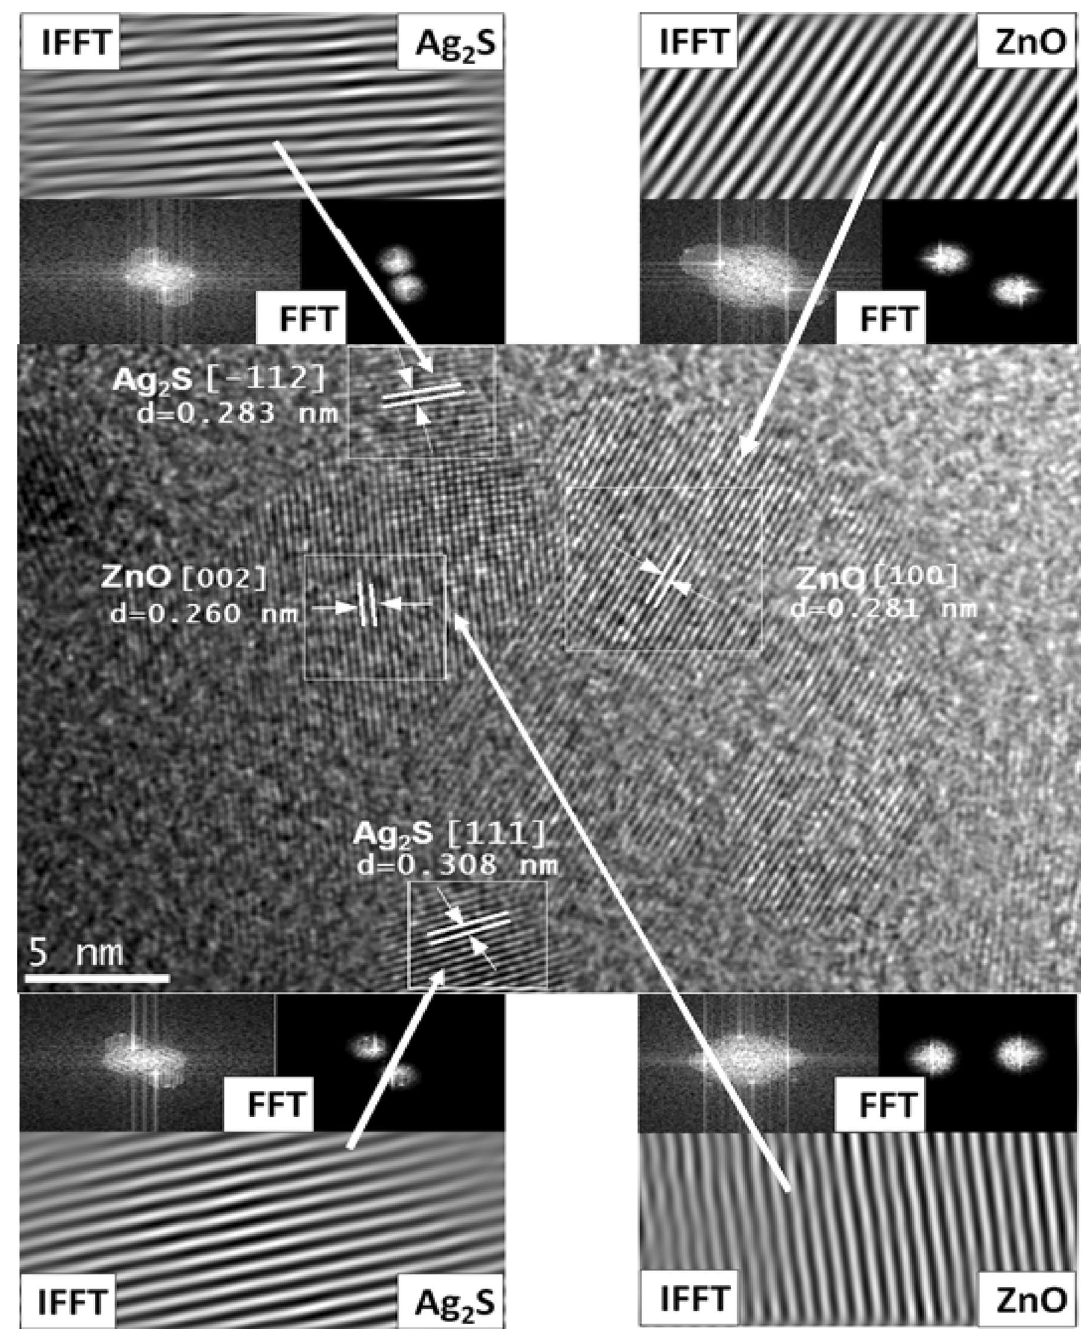
Figure 6. HRTEM image of the Ag 2 S/ZnO and diffraction patterns via FFT and